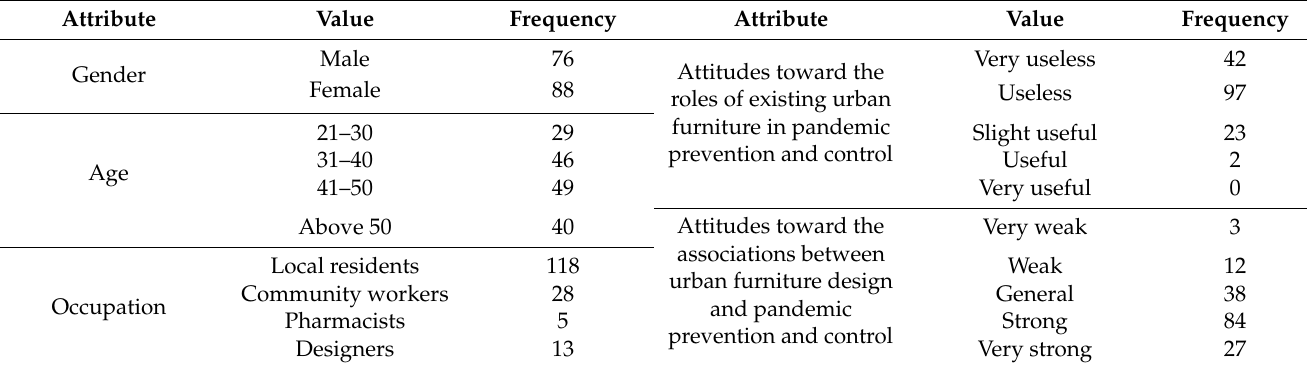
Table 3. Demographic information and partial contents of the questionnaire survey.